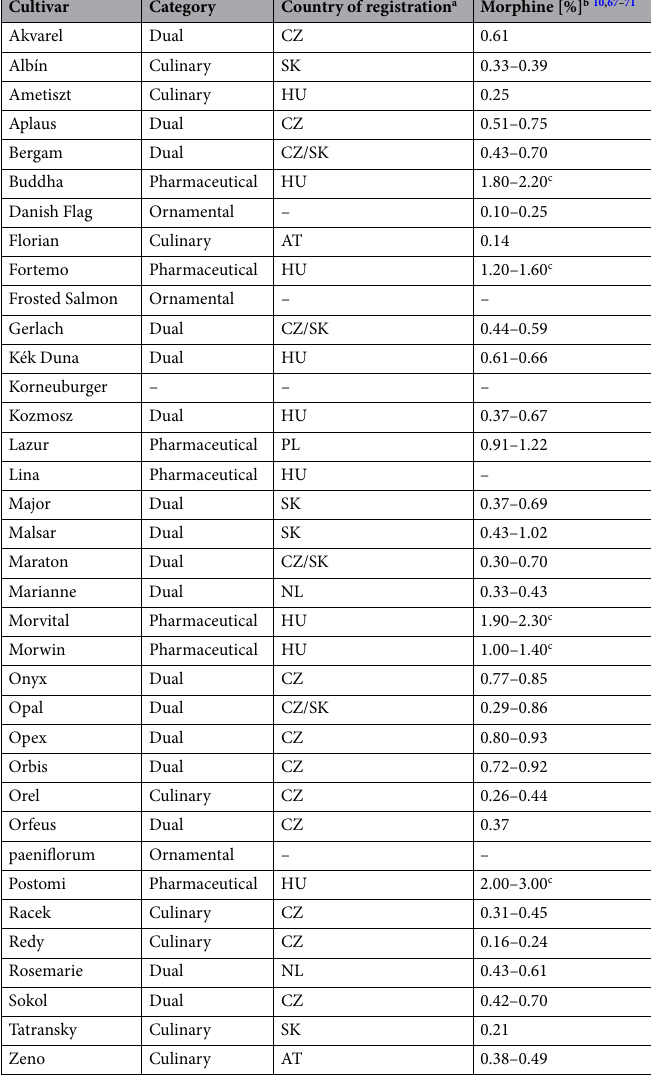
Table 1. List of analysed poppy cultivars. a AT—Austria, CZ—Czech Republic, HU—Hungary, NL— Nederlands, PL—Poland, SK—Slovak Republic. b Lowest and highest value found. c Values provided by Research Institute for Medicinal Plants and Herbs